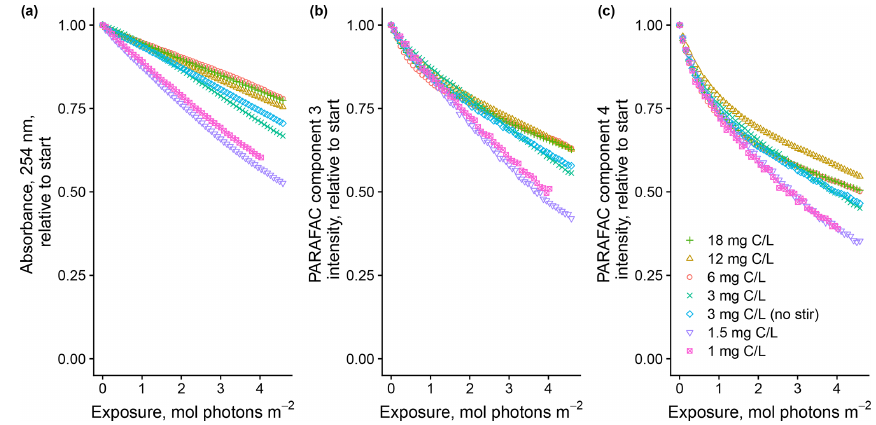
Figure 4. Photodegradation time series of (a) absorbance at 254nm and (b, c) fluorescence intensities of PARAFAC components three and four, relative to the starting values. Data are shown from experiments with SRNOM PPL that varied the approximate DOC concentrations.